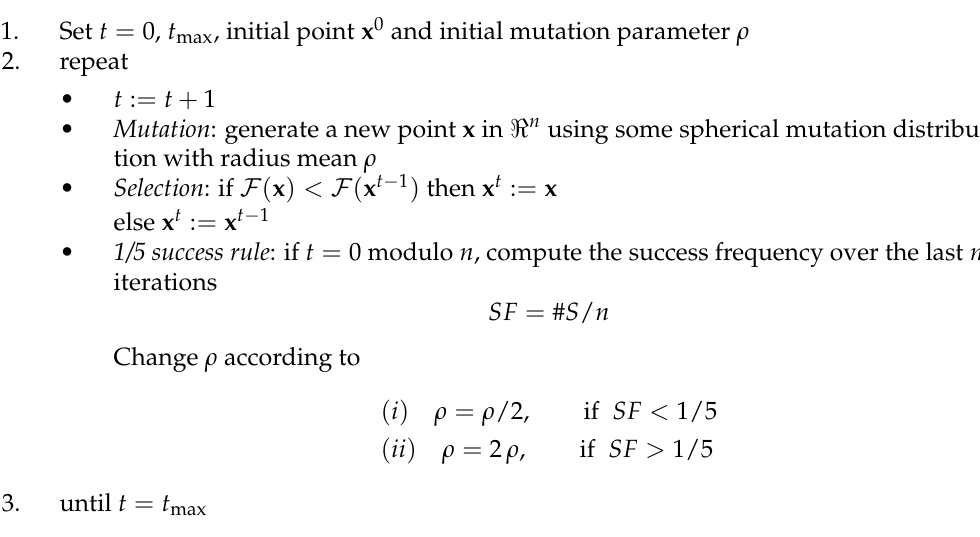
Algorithm 1 Elitist ES with 1/5 success rule.